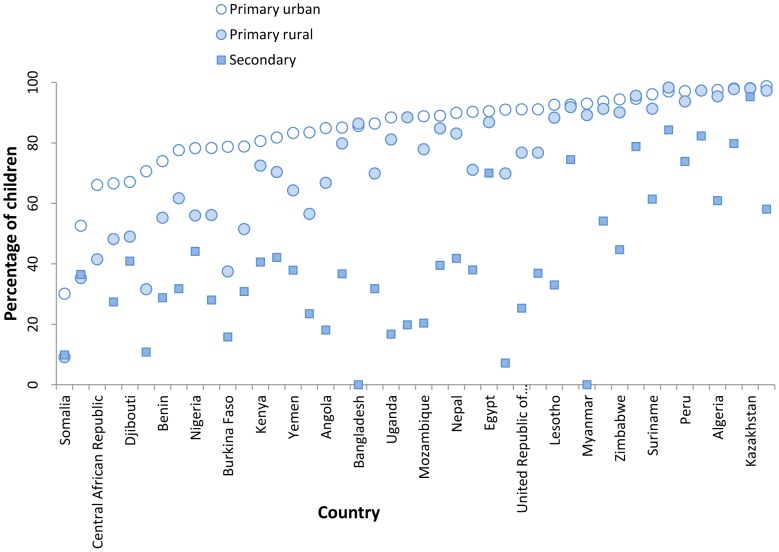
School attendance for a selection of countries.This figure was generated by data published by UNICEF for 2005–2010 [41].. For each country there is net attendance rate at primary, in urban (open circles) and rural areas (closed circles) and a net attendance rate for secondary schools (filled squares).